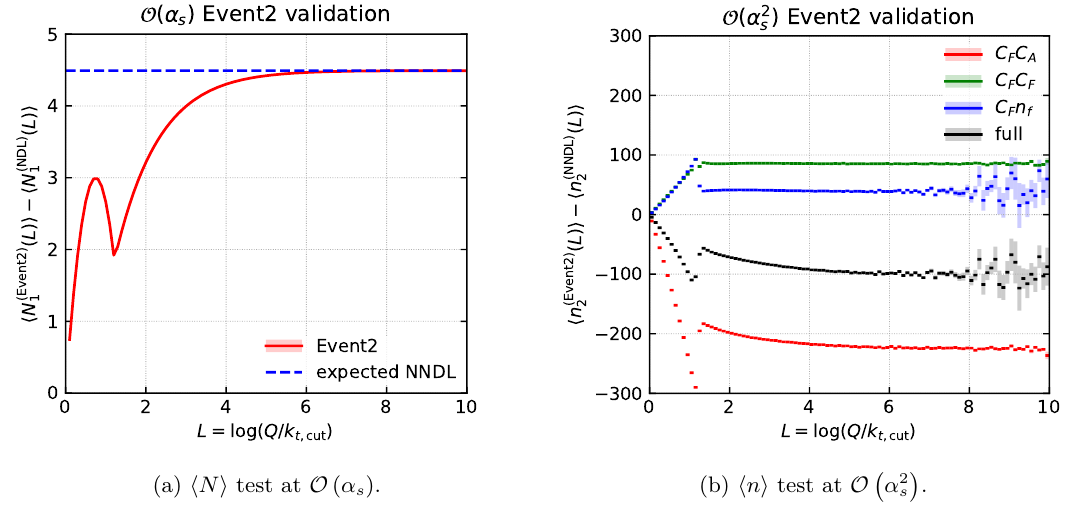
Figure 7. Comparison between our NNDL calculation expanded in series of α s and exact fixed-order results obtained numerically with Event2 : (a) the multiplicity difference h N (Event2)